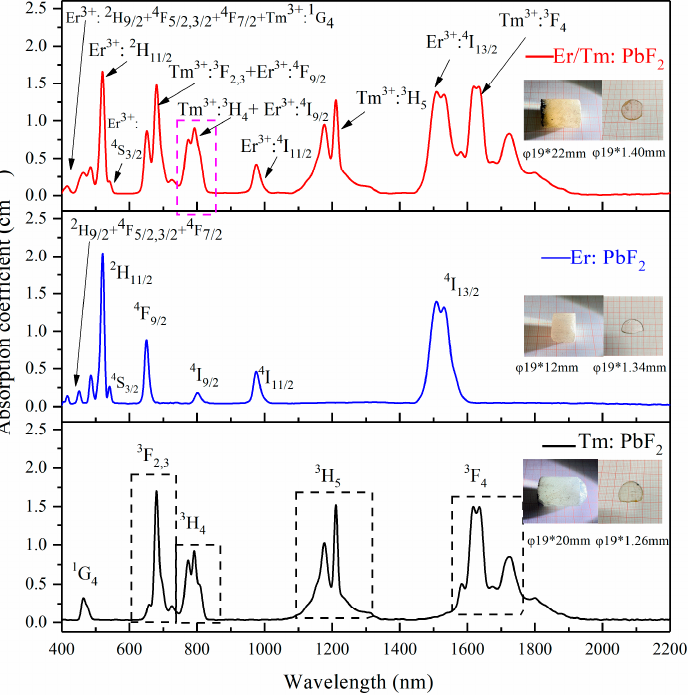
Figure 3. Absorption spectra of Tm: PbF 2 , Er: PbF 2 , and Er/Tm: PbF 2 crystals ranging from 400 to 2200 nm at room temperature. (Illustration: the photos of Er/Tm: PbF 2 , Er: PbF 2 , Tm: PbF 2 crystals and their cut and polished crystal pieces, respectively.)